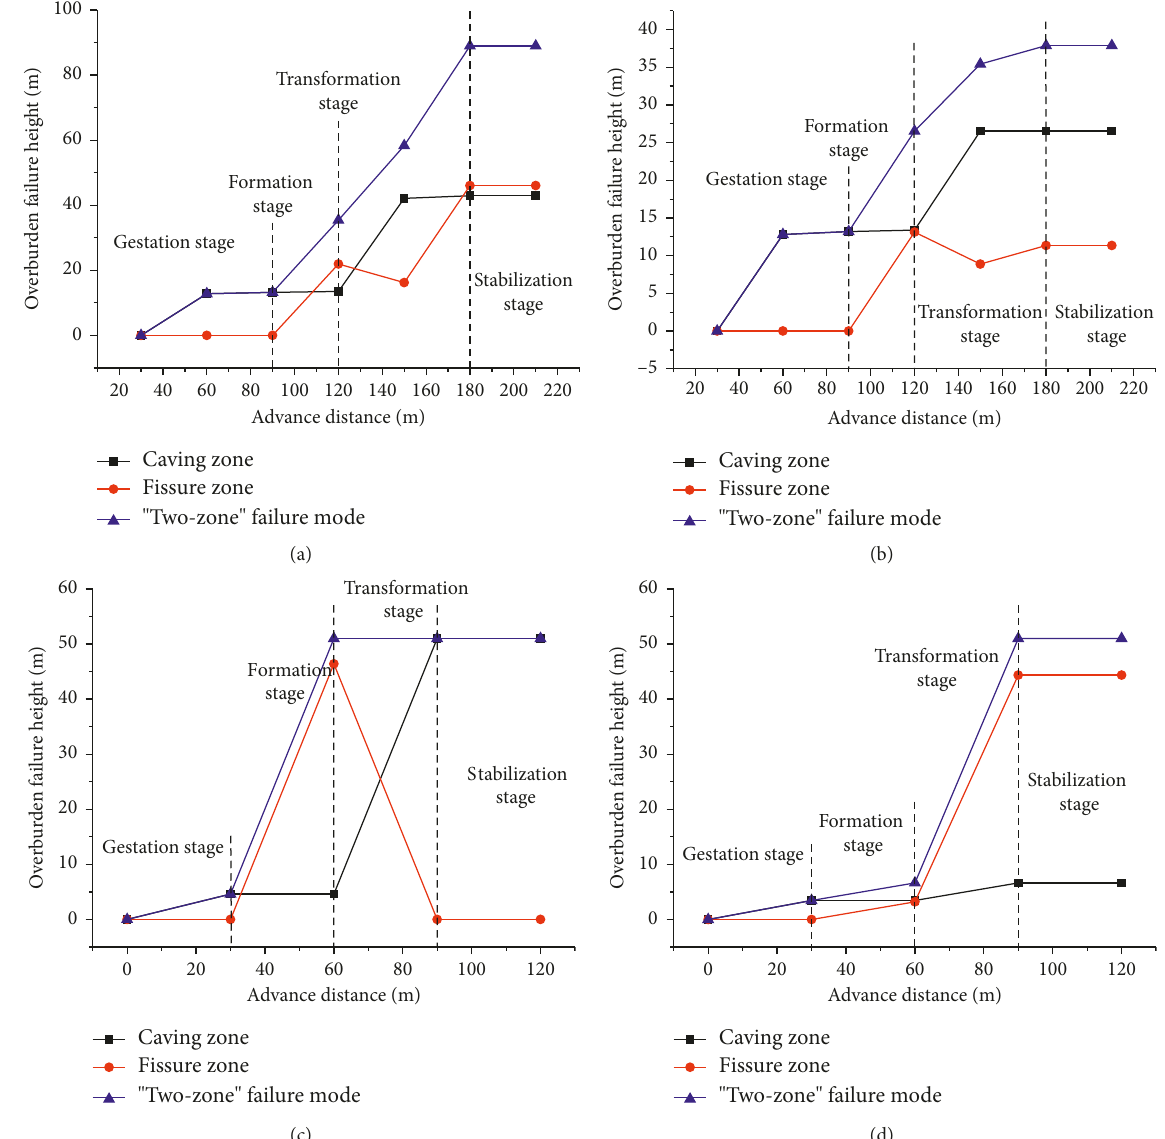
Figure 9: “Two-zone” failure mode evolution process of different key strata structure and mining height. (a) Multiple key strata structure (mining height is 5.3m). (b) Multiple key strata structure (mining height is 3.0 m). (c) Composite single key strata structure (mining height is 5.3m). (d) Composite single key strata structure (mining height is